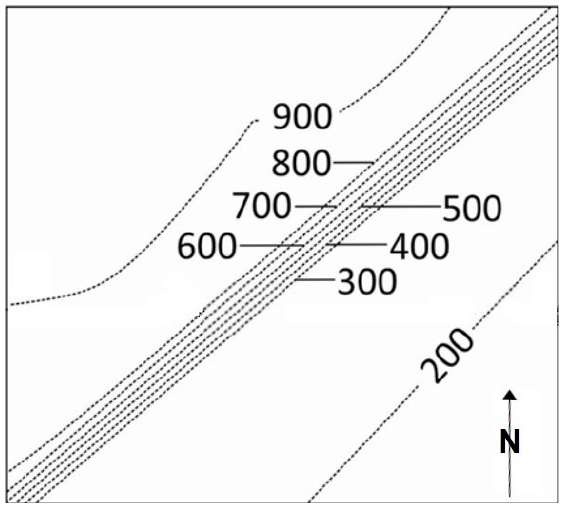
Figure 6. Example of an exercise. A precipice is shown on a piece of topographic map. The students had to choose the correct answer regarding its orientation on the map. The choices were (a) N–S;